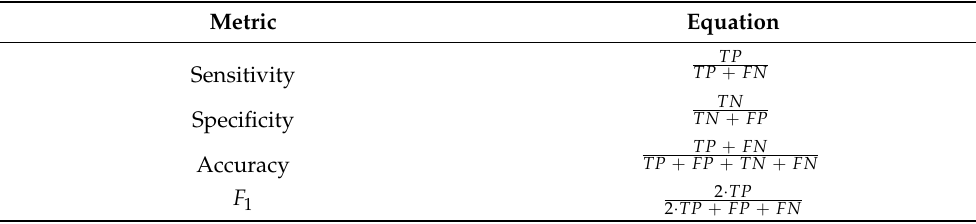
Table 2. Evaluation metrics adopted during the relevance feedback